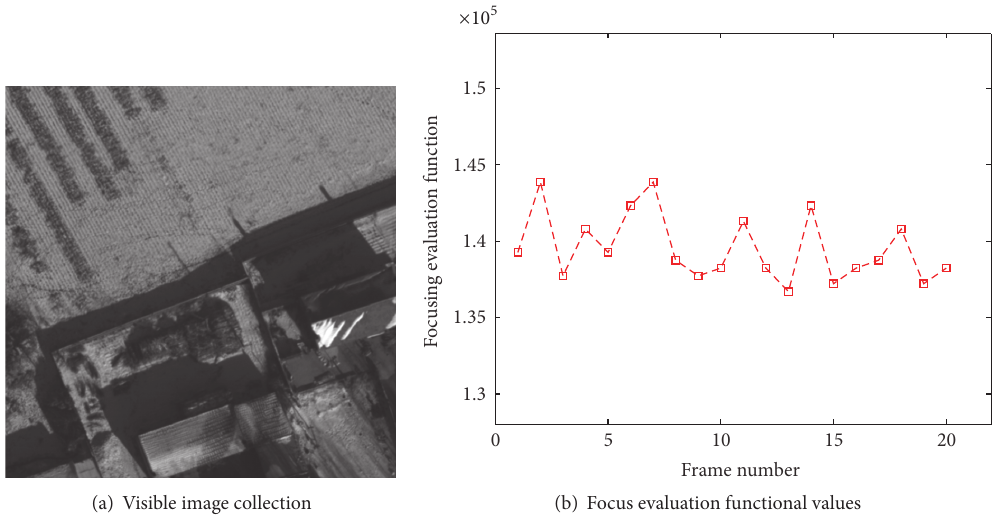
Figure 8: Visible image collection and the corresponding values of focus evaluation function.